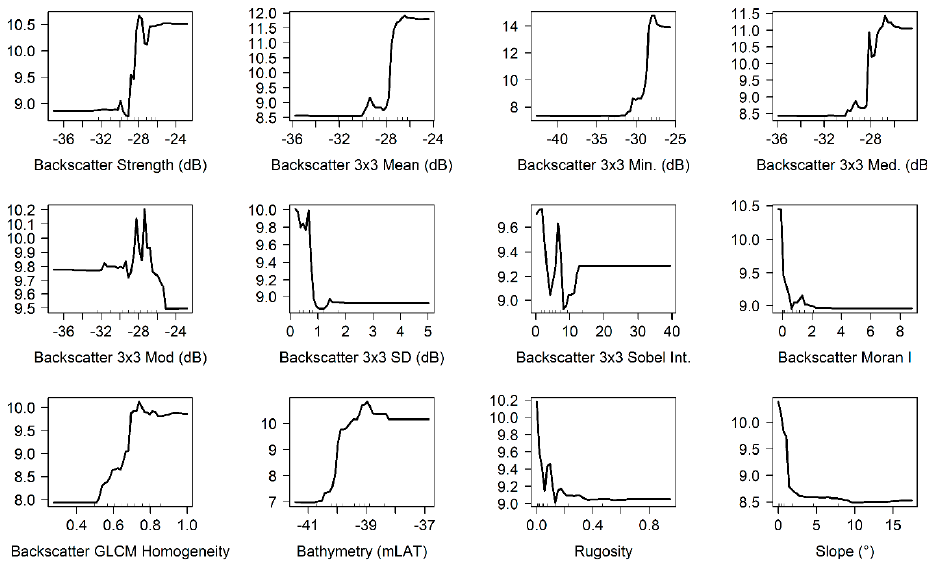
Figure 5. Partial dependence plots. Y -axis: response variable. X -axis: feature values with deciles (tick marks).